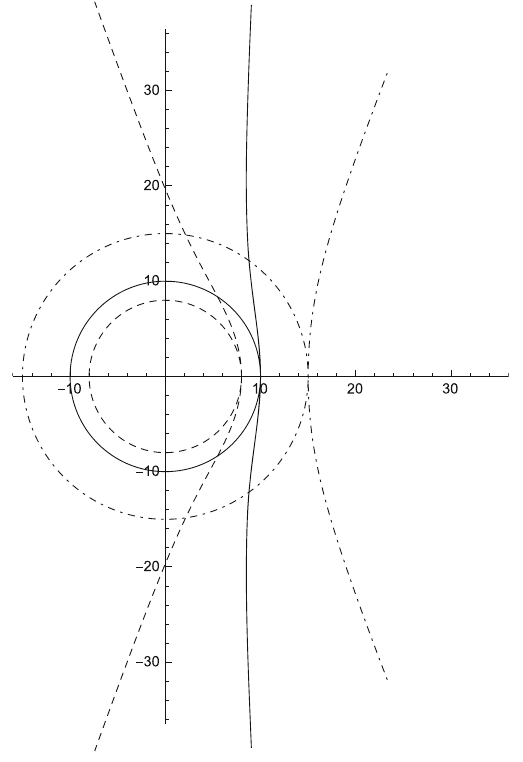
Fig. 7 The deflection of light for L = 1 and z = 100. The dashed line corresponds to E = 0 . 0080 with r D = 8, the continuous line corresponds to E = 0 . 0063 with r D = 10 and the dot-dashed line corresponds to E = 0 . 0037 with r D =